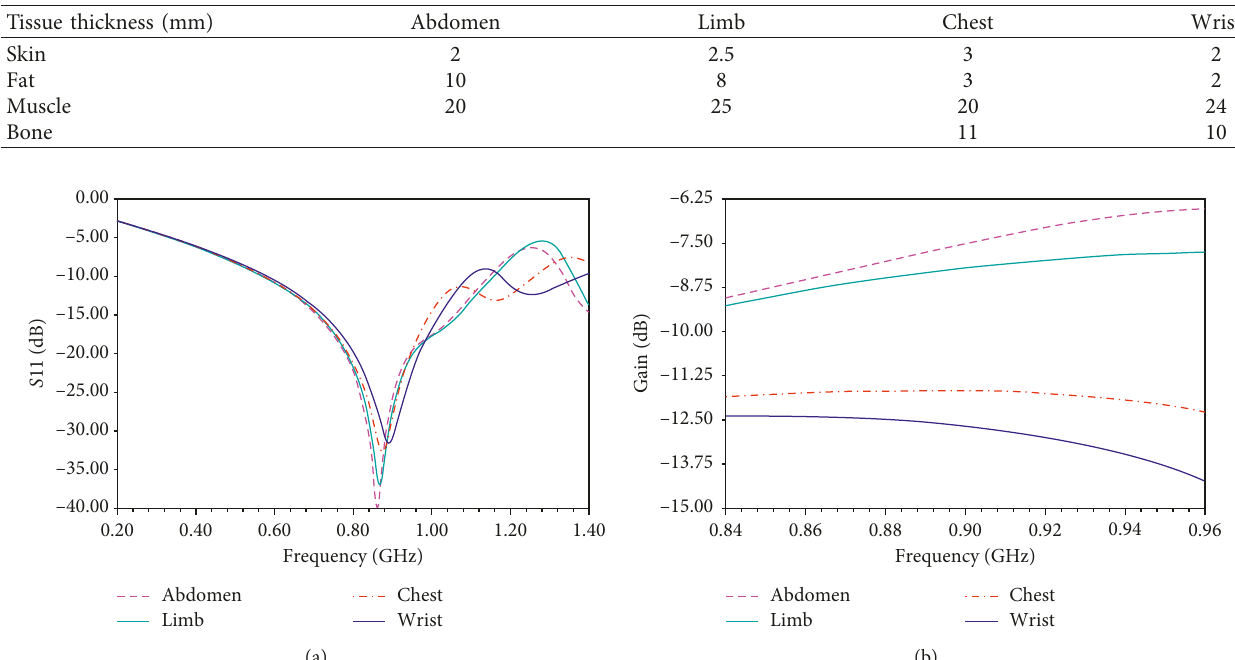
Figure 12: Simulated input resistance and reactance of the first proposed tag antenna on the layered elliptical model and planar model. Table 2: Thicknesses of different tissues for some human body parts in the planar model.